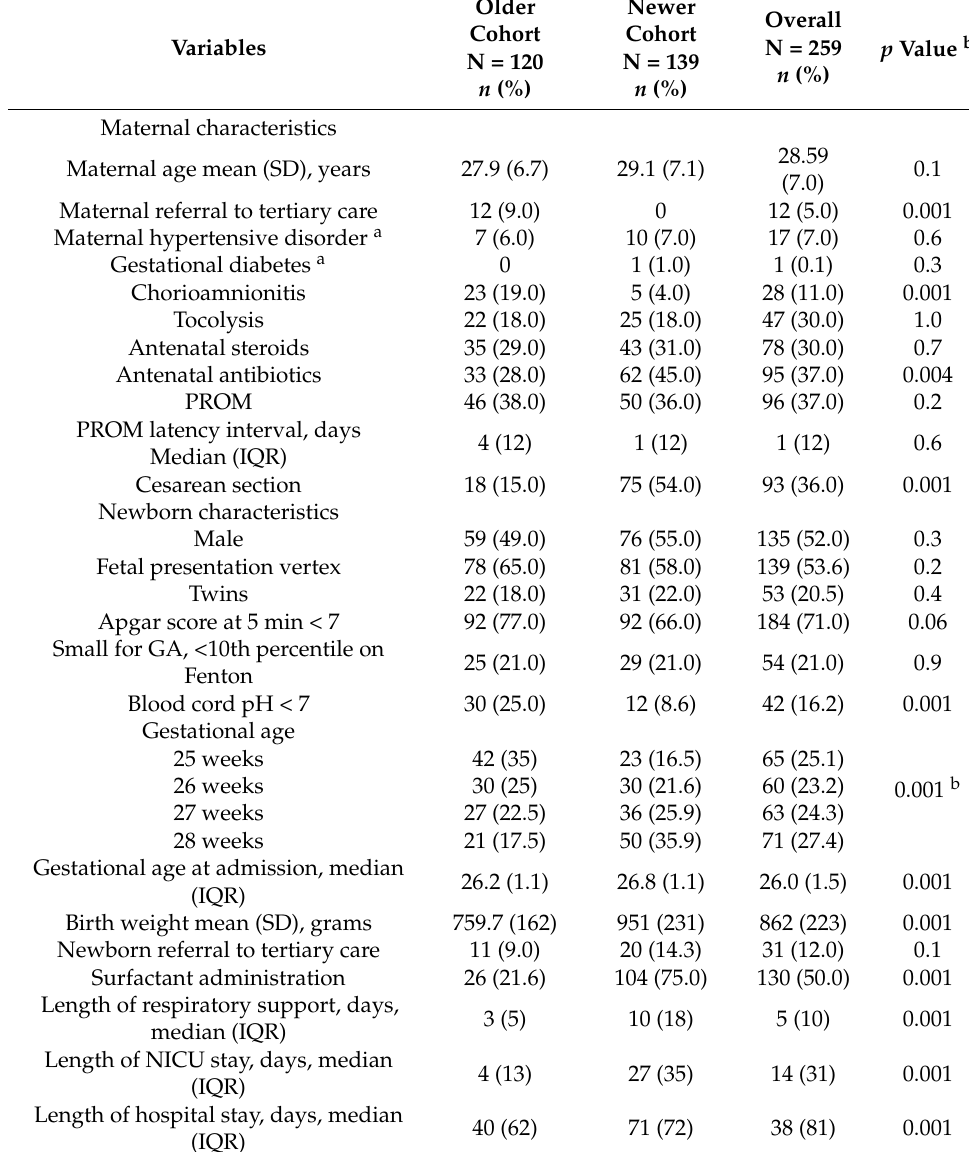
Table 1. Baseline characteristics of the mothers and their newborns according to study